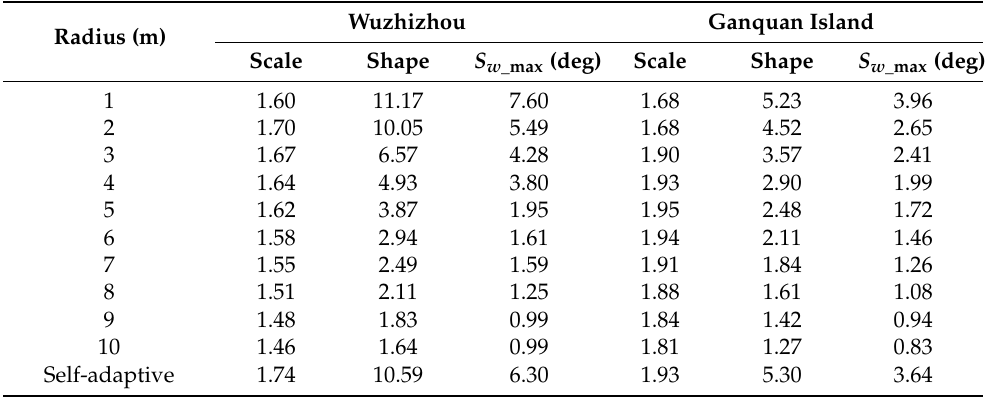
Figure 18. Parameters of the Weibull function fitting for the water surface inclination estimation with different neighborhood point selection radii in the experimental areas. Table 9. Fitting parameters for the Weibull functions with different neighborhood point selection radii.